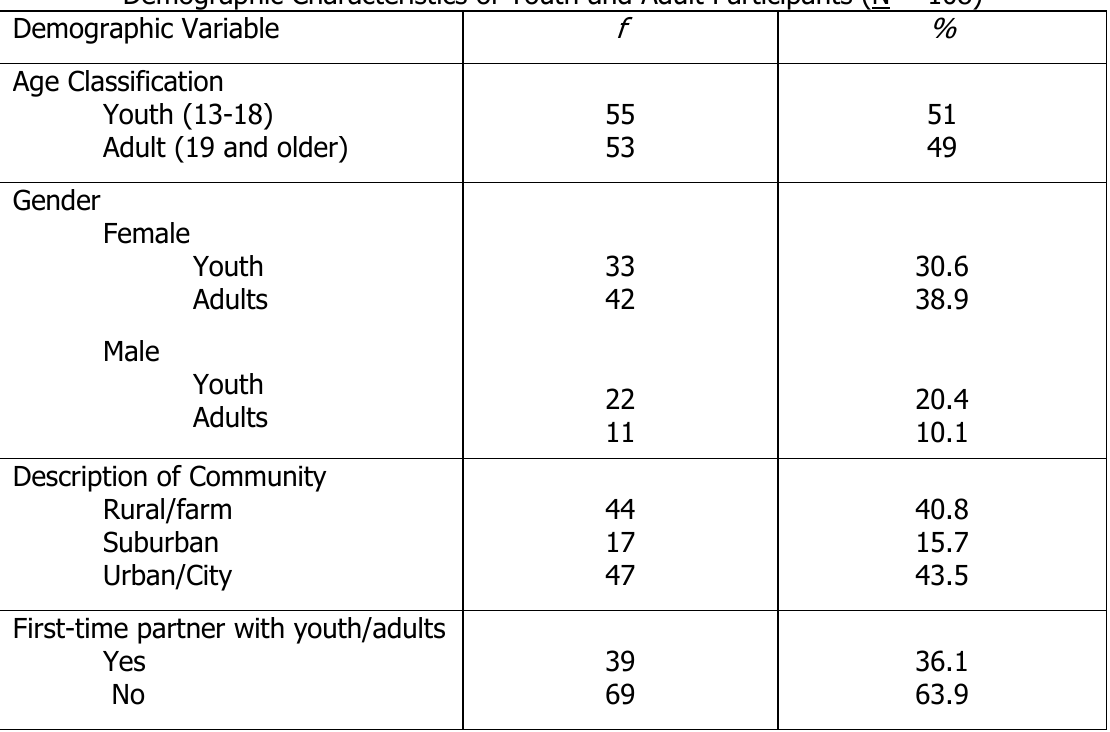
Demographic Characteristics of Youth and Adult Participants (N = 108) Demographic